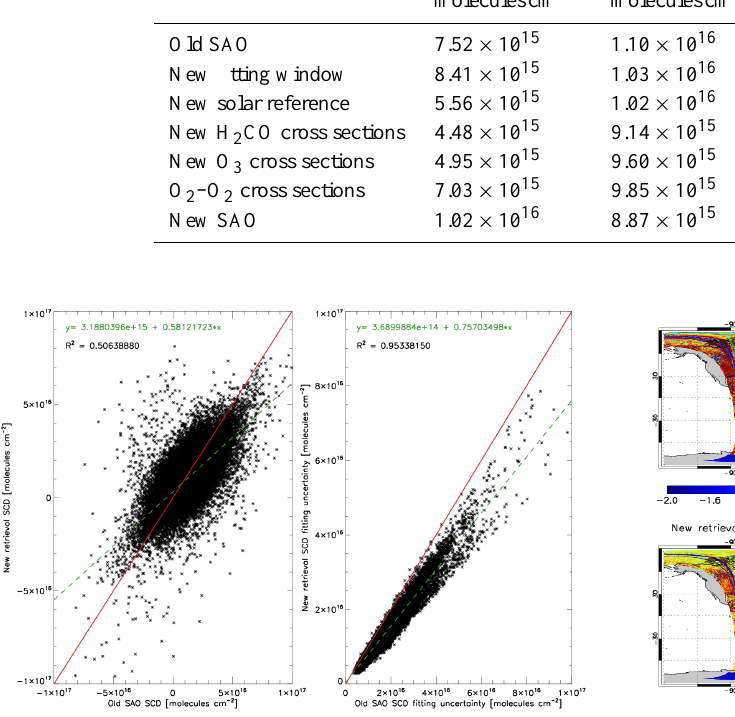
Figure 8. Scatterplots for Orbit 43214 comparing the old SAO re- trieval and new SAO retrieval of SCDs and SCD fitting uncertain- ties.